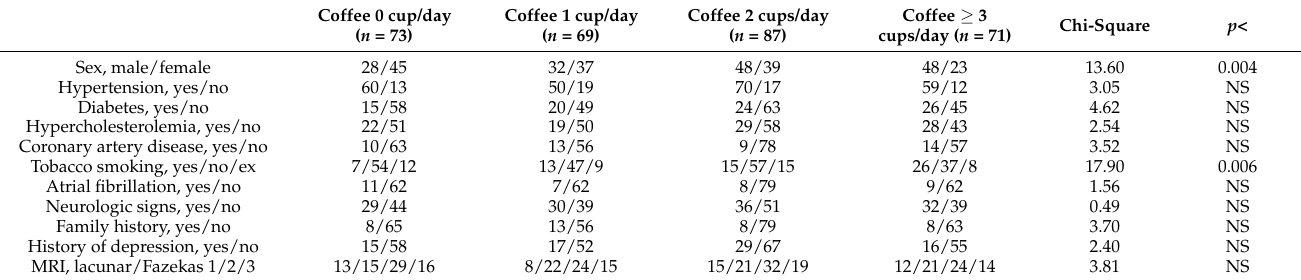
Table 2. Comparison of categorical variables obtained from the four groups of